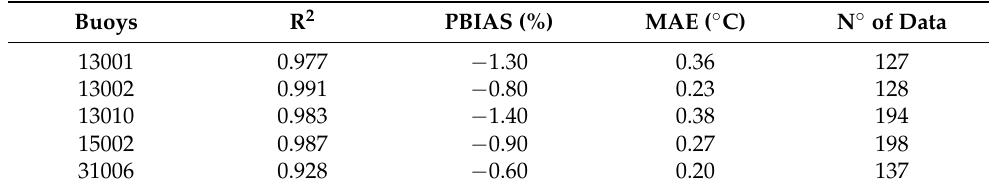
Table 2. Validation of the SST ERA5 with monthly mean temperature in 5 Atlantic buoys between 1997 and 2019.